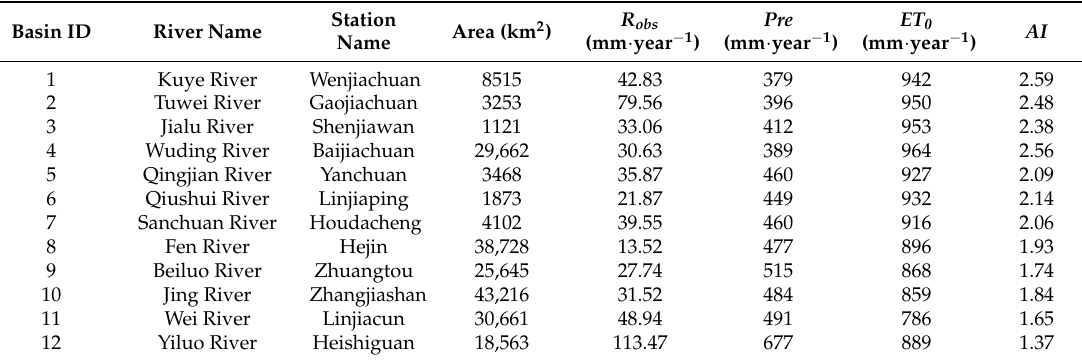
Table 1. Descriptions of the 12 river basins located in the Loess